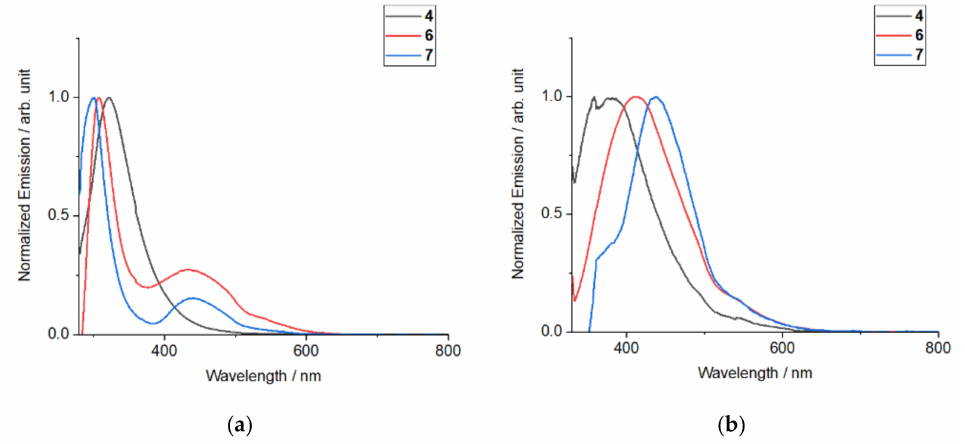
Figure 4. ( a ) Room-temperature emission spectra of 4 , 6 and 7 in solution after excitation at 268 nm (10 − 5 M in CH 3 CN). ( b ) Room-temperature emission spectra of 4 , 6 and 7 in solution after excitation at 317 nm (10 − 5 M in CH 3 CN).